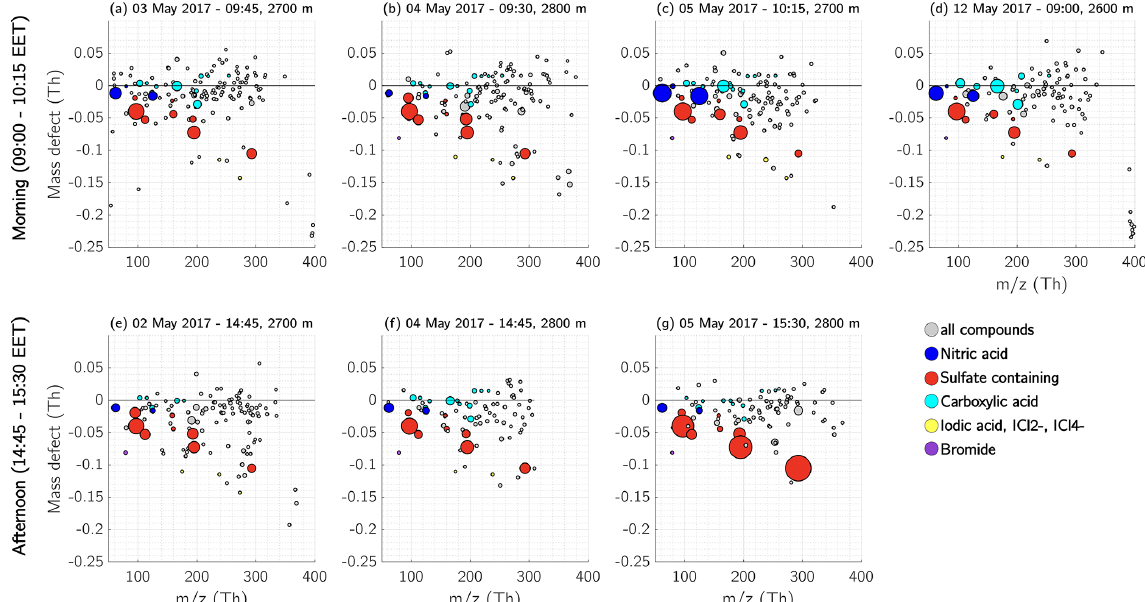
Figure 18. Mass defect of the free troposphere during morning and afternoon. Each panel from (a) to (d) shows the detected ions in the FT during morning measurements (between 09:00–10:15EET); the panels (e) to (g) show the measurements during the afternoons (between 14:45–15:30EET). Nitric-acid-containing ions are coloured dark blue, ions and clusters with sulfuric acid, MSA, or both, and the SO − ion are coloured red. The compounds containing carboxyl functional groups are depicted in cyan, and iodic-acid- and iodine-containing compounds in yellow. The size of the dots corresponds to the measured signal (ionss − 1